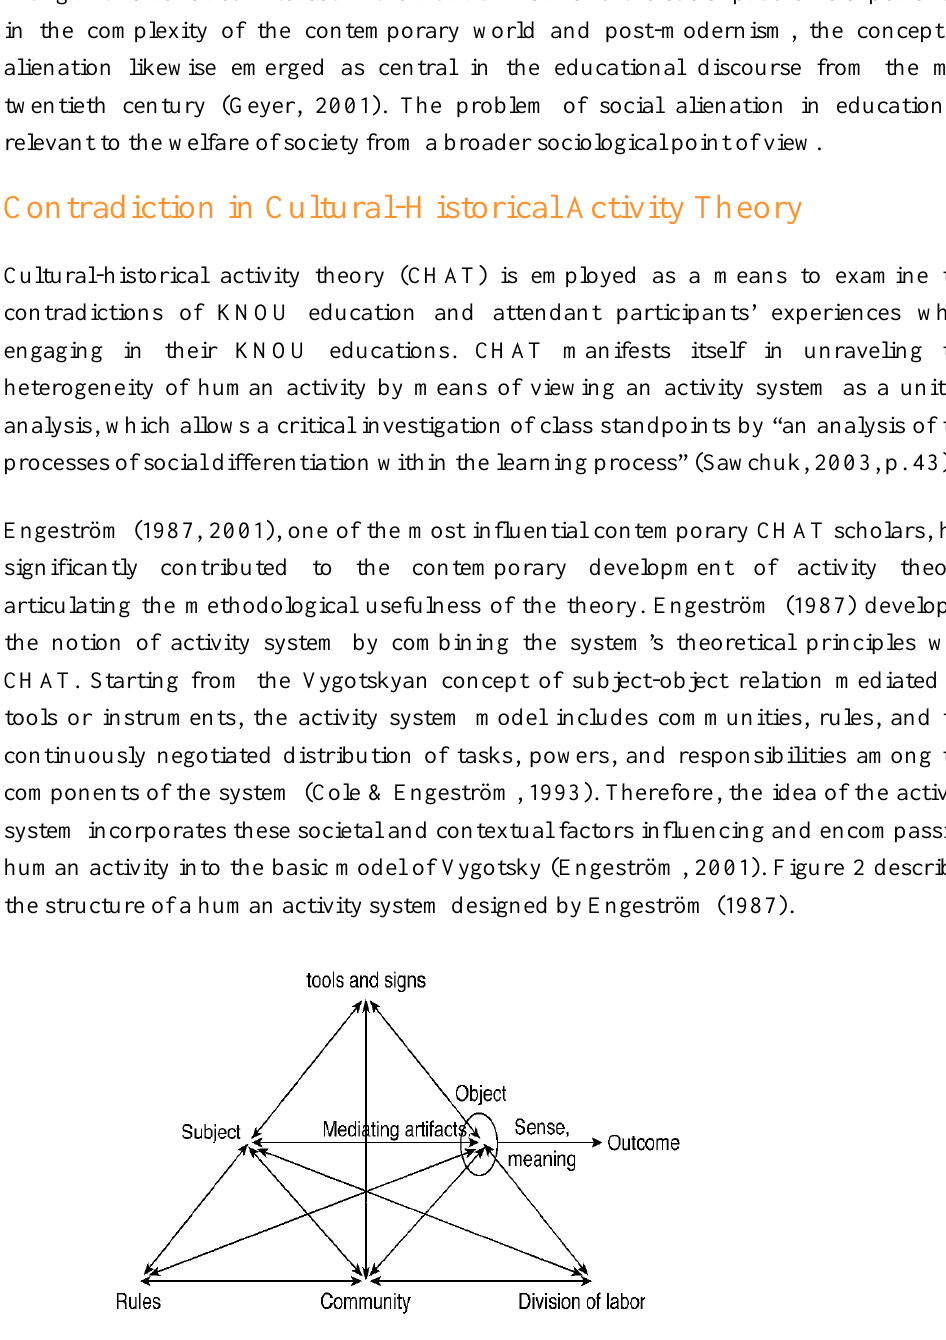
Figure 2 . The structure of a human activity system (Engeström, 1987, p.